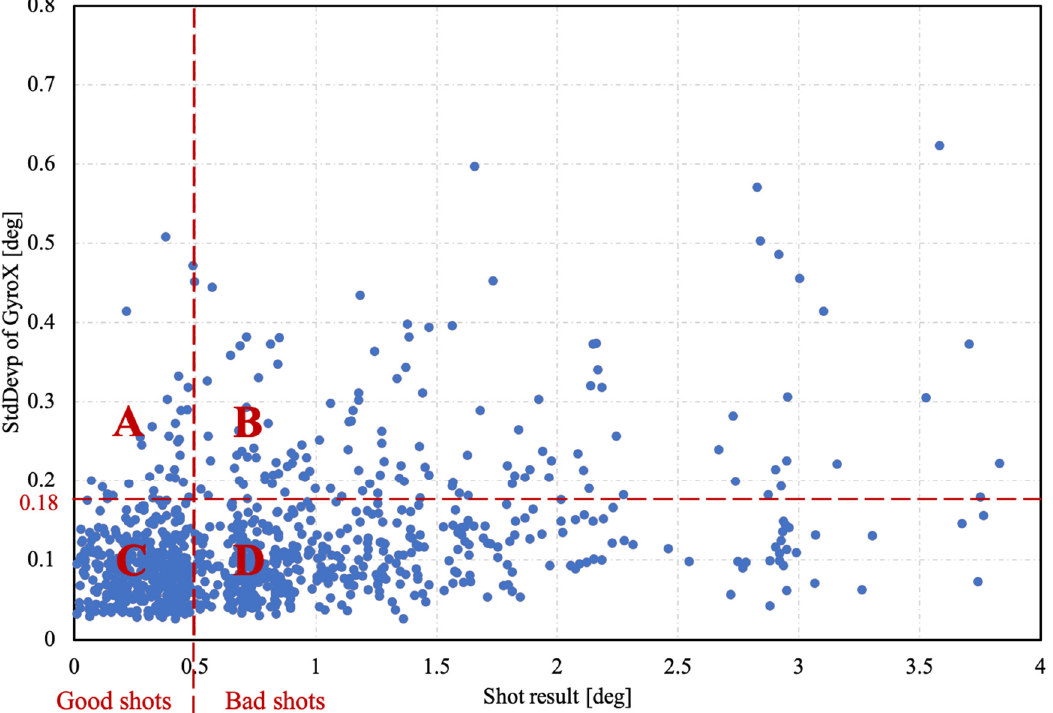
Figure 8. Detection of outliers denoted as lucky shots and the shots with aiming error. Area A is the area of lucky shots, the points in Area B and C represent the hand movement detection regions, and Area D most probably is the area denoting points of aiming error.